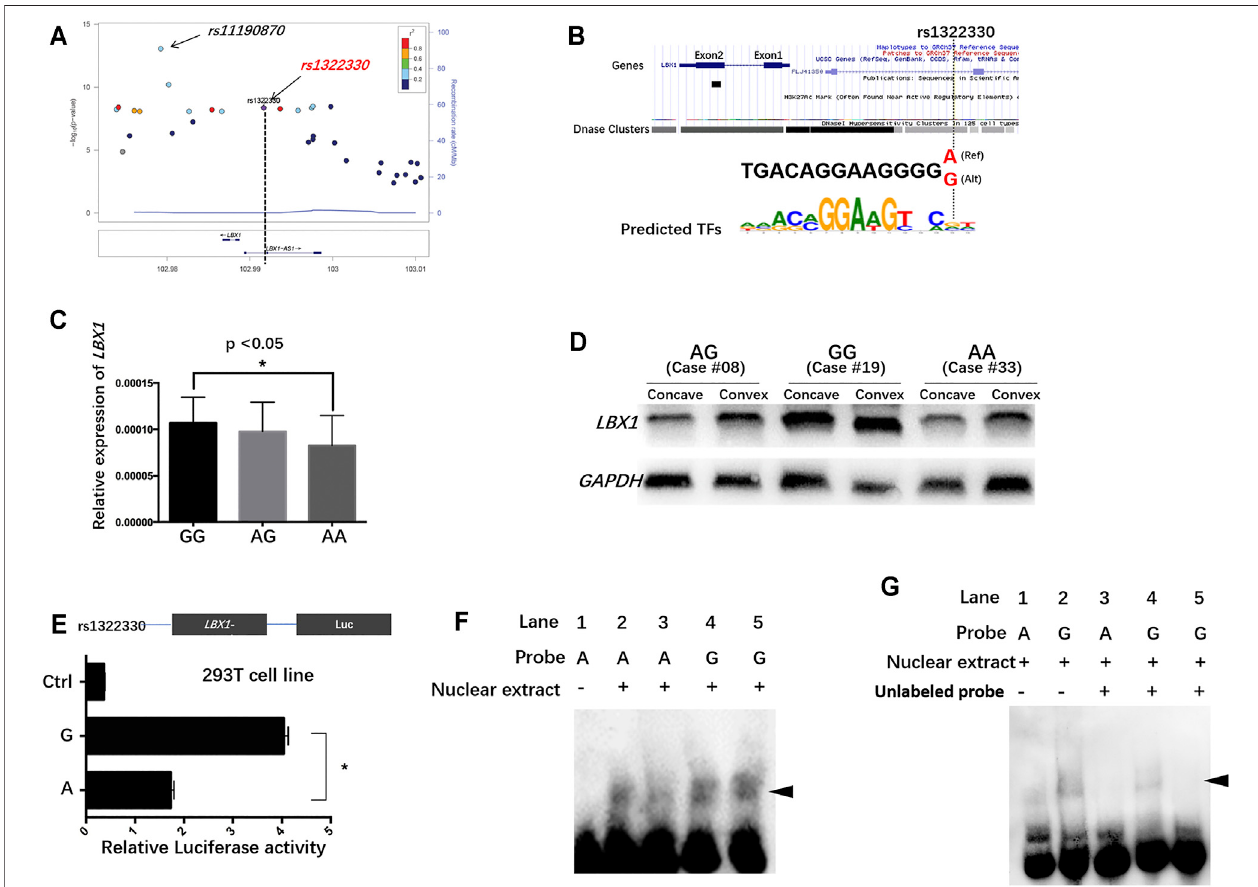
FIGURE 1 | The regulatory mechanism underlying LBX1 expression in the paraspinal muscles of adolescent idiopathic scoliosis (AIS). (A) Fine-mapping of the previously reported susceptible loci showed that rs1322330, located in the promoter region of LBX1 , was remarkably associated with AIS with genome-wide signi fi cance( p (cid:1) 4.25 × 10 − 9 ). (B) Genomebrowserofrs1322330indicatedalteredactivityofDNaseatthislocus.ThevariantA/Gispredictedtoalterthebindingaf fi nity ofcertaintranscriptionalfactors. (C) PatientswithgenotypeAAofrs1322330werefoundtohaveremarkablydecreased LBX1 mRNAexpressionascomparedwith those withgenotype GG. (D) WB analysiscon fi rmedthatgenotypeAAwasindicative ofremarkably lower LBX1 protein expression inparaspinalmuscles. (E) Luciferase